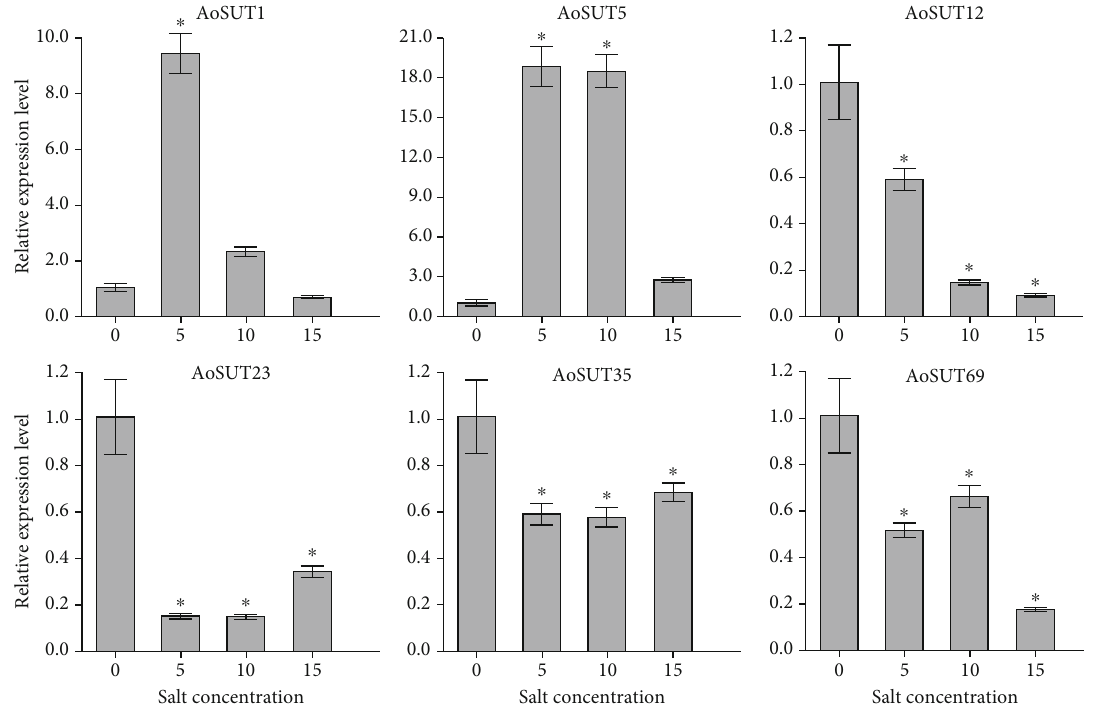
Figure 7: Expression pro fi les of six selected AoSUT genes in response to salt stress determined by qRT-PCR. The bars represent the average ( ± SE) of biological repeats. Asterisks indicate statistical di ff erence between groups (Student ’ s t test): ∗ p < 0 : 05 .